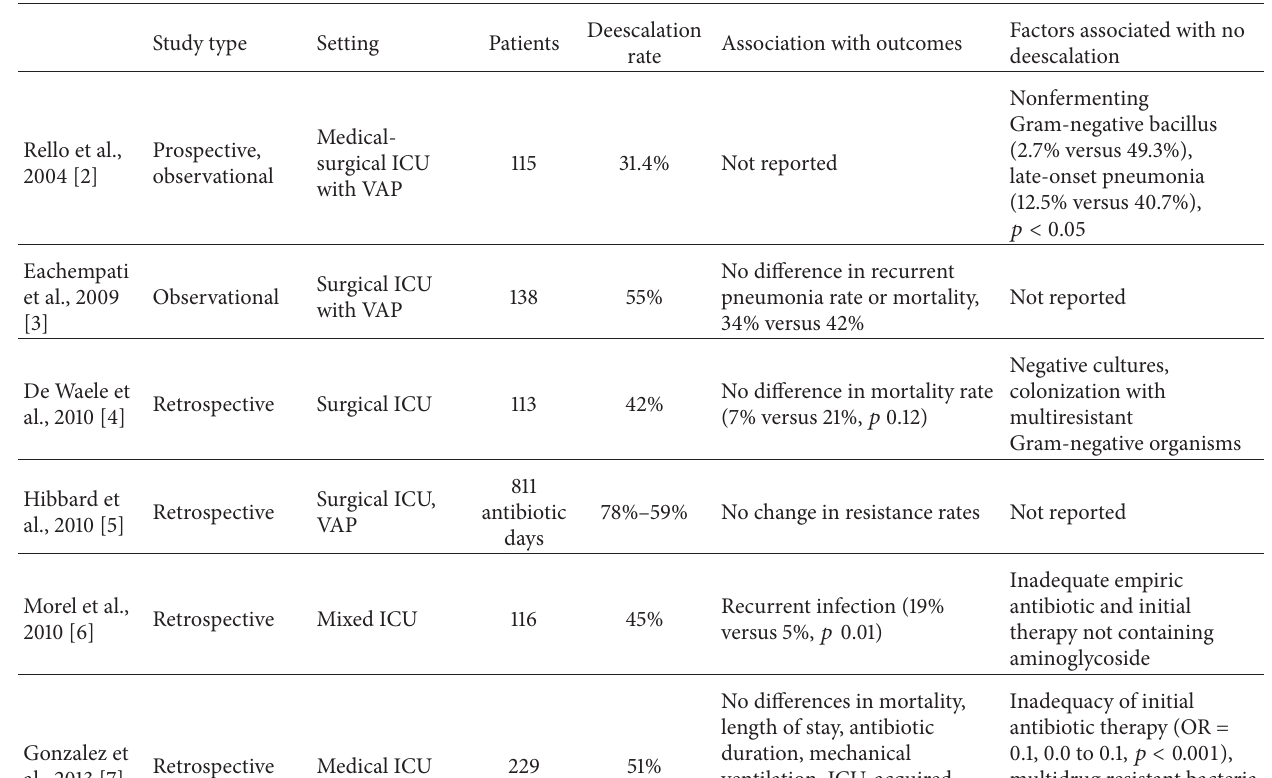
Table 5: Summary of studies on antibiotic